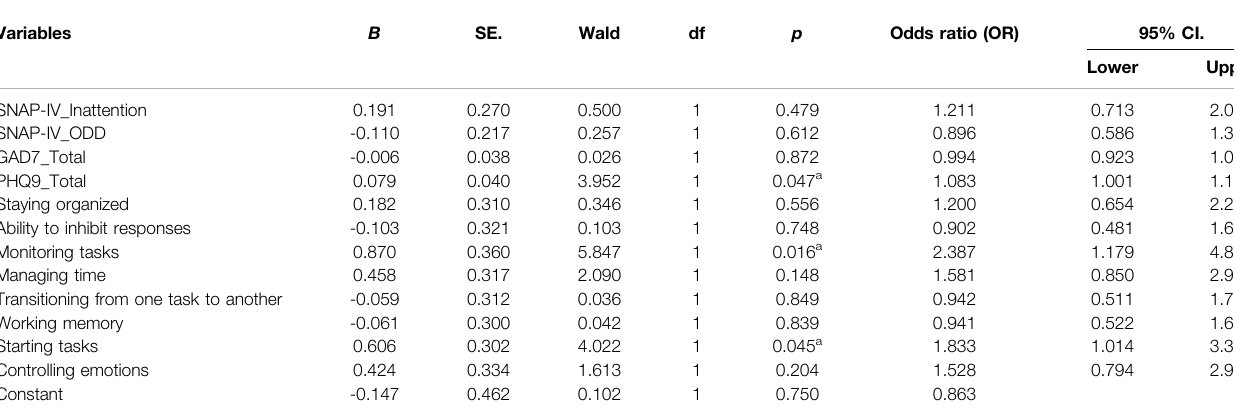
TABLE 5 | Stepwise logistic regression model predicting challenges with online classes for children with ADHD.